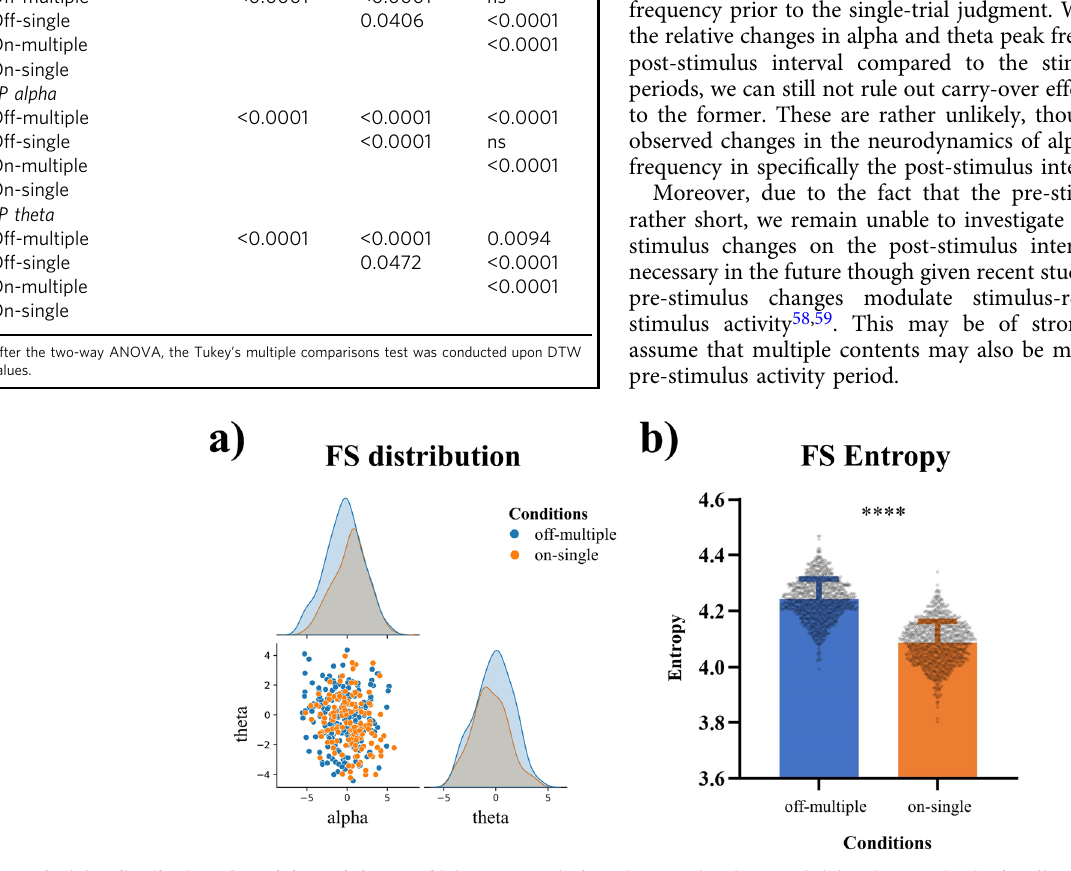
Fig. 6 The joint distribution of FS alpha and theta and joint entropy (JE). a The joint distribution of alpha/theta FS (and FP). Off-multiple and on-single ’ s distribution could be discriminated in FS with overlaps. b The joint entropy (JE) results in FS. JE values for off-multiple thoughts are signi fi cantly higher than those for on-single thoughts. The error bar means SD. **** p < 0.0001.